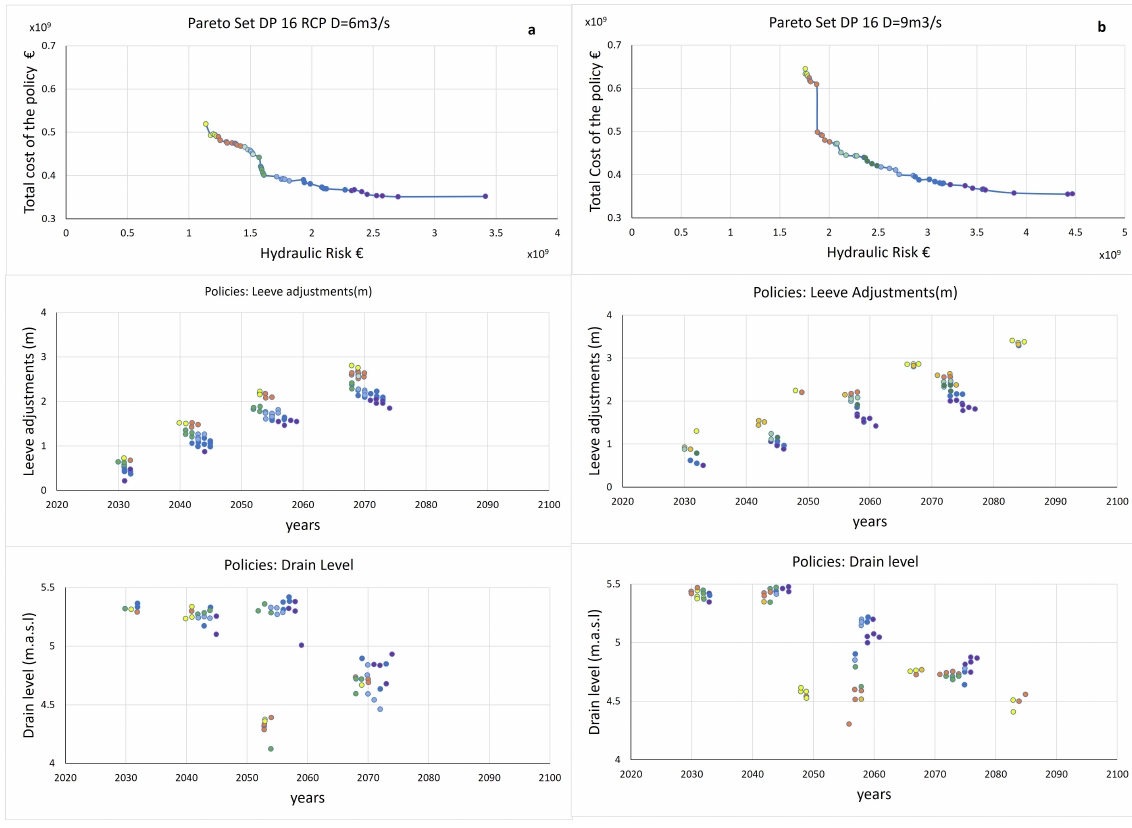
Figure 14. ( a , b ) Size and timing of Flood defence constructions for the Pareto set optimal solutions referred to scenario 2 of Table